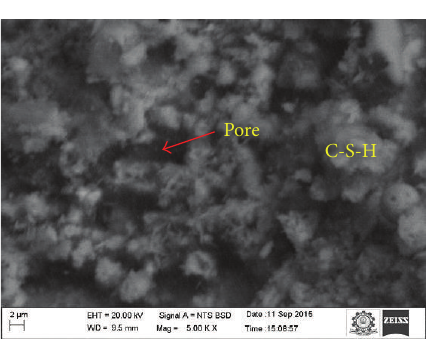
Figure 2: SEM image for SFCS0 specimen.